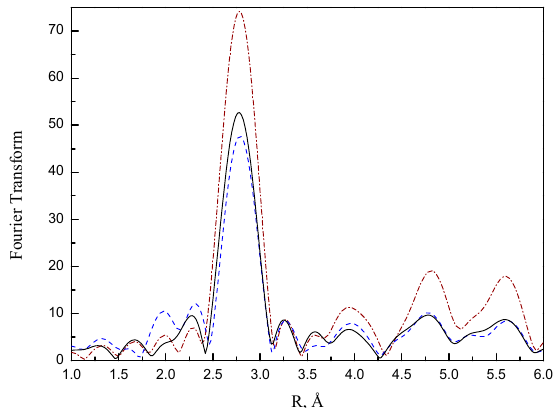
Figure 8. Magnitude of the EXAFS Fourier transform (3.5 < k 3 < 14.0, Pt–Pt phase and amplitude corrected) for (a) fresh Pt/NaY-SiO 2 (black solid line), (b) PtR (HF) (blue dash line), (c) PtR (LF) (brown dot-dashed line).